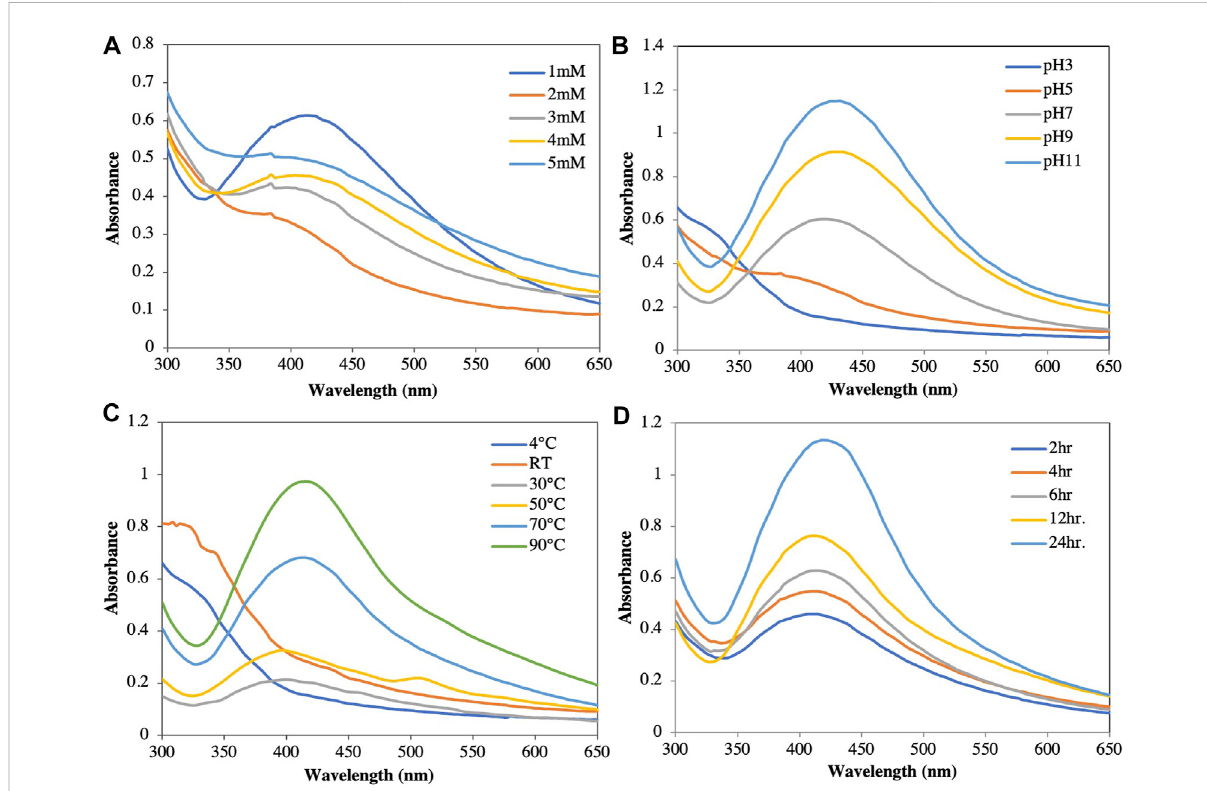
FIGURE 2 Optimization of synthesis of silver nanoparticles at different parameters. (A) AgNO 3 concentration. (B) pH. (C) Temperature. (D) Time